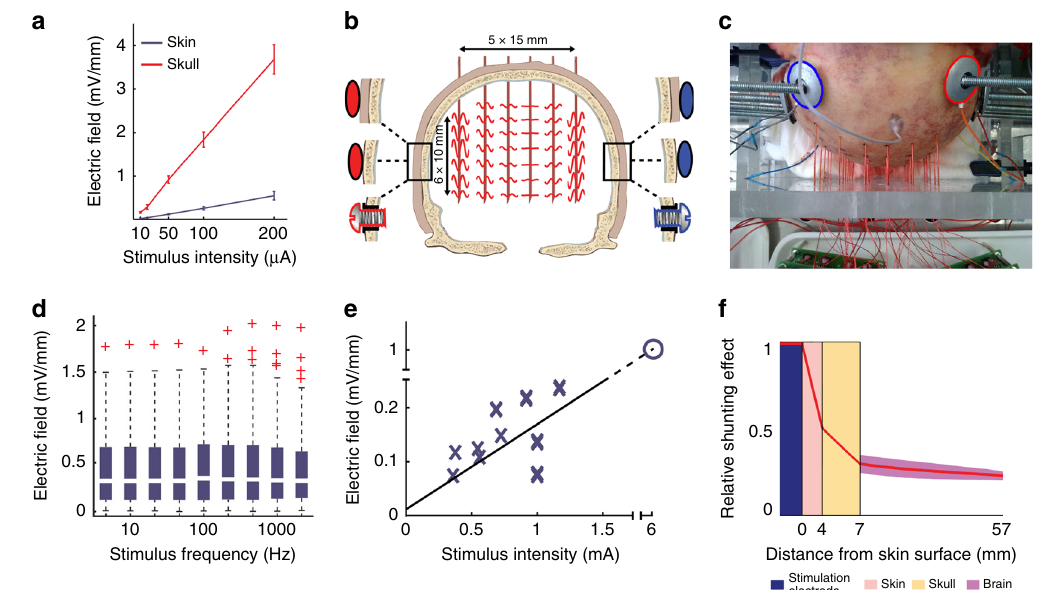
Fig. 4 Current loss of TES in rodents and in human cadaver brains. a Compared to subcutaneous stimulation (red), transcutaneous stimulation (blue) generated several-fold weaker electric fi elds in a rodent model. b Schematic of the experimental arrangement for transcutaneous, subcutaneous, and epidural stimulation in cadavers, in a coronal plane. c Photograph of the cadaver skull with drilled holes and inserted matrix of recording electrodes. Stimulation electrodes, marked by blue and red circles for negative and positive polarity, respectively, were fi xed to the skull. d Effect of stimulus frequency on intracerebral voltage gradients. Stimulus frequency between 5 and 1000Hz has a minor effect on intracerebral gradients. e Extrapolation from measurements in human cadavers (blue crosses) suggests that approximately 6 mA current applied across the skin would induce 1 V/m intracerebral electric fi eld (blue open circle). f Attenuation of charge fl ow (red line) through scalp (pink), skull (yellow), and brain (dark pink), as measured in human cadaver heads. Figure adapted from Figs. 1, 4, 5 in Voroslakos et al., (2018) 35 , under the Creative Commons